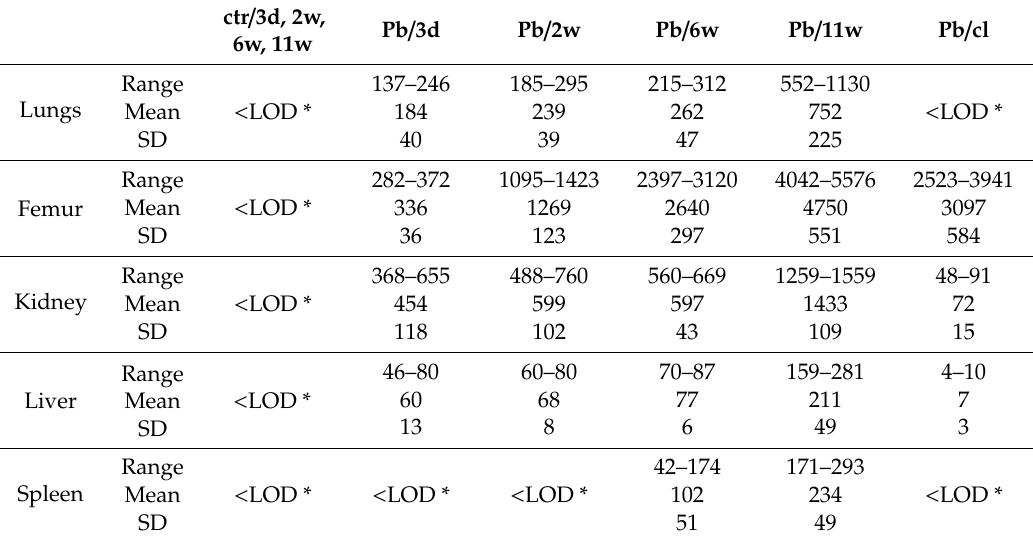
Table 2. The concentration of Pb (ng / g) in organs following Pb(NO 3 ) 2 NP inhalation determined by atomic absorption spectrometry